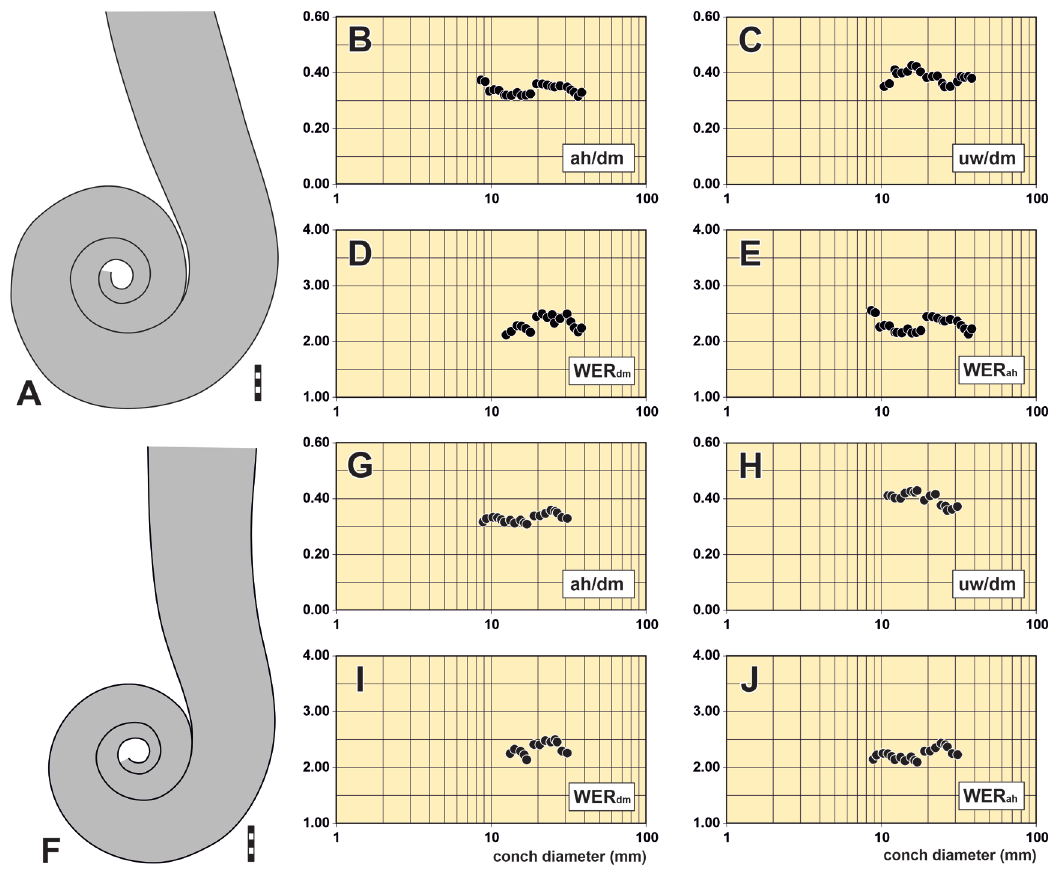
Fig. 67. Trilacinoceras knoefleri sp. nov. A . Coiling outline of holotype MB.C.11658. B–E . Conch proportions and coiling rates of holotype MB.C.11658. F . Coiling outline of paratype MB.C.30559. G–J . Conch proportions and coiling rates of paratype MB.C.30559. Scale bar units = 1